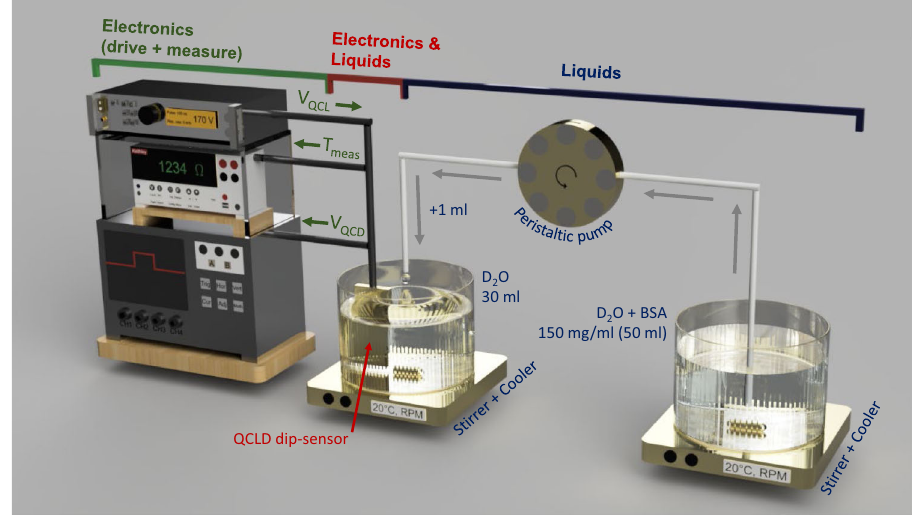
Fig. 3 | Concentration measurement setup. A peristaltic pump continuously pumps the stock solution (50ml BSA in D 2 O at 150mgml − 1 ) to the measurement beaker, initally fi lled with pure D 2 O. The QCLD-sensor is directly submerged in this second beaker to monitor the concentration changes. Nature Communications| (2022)